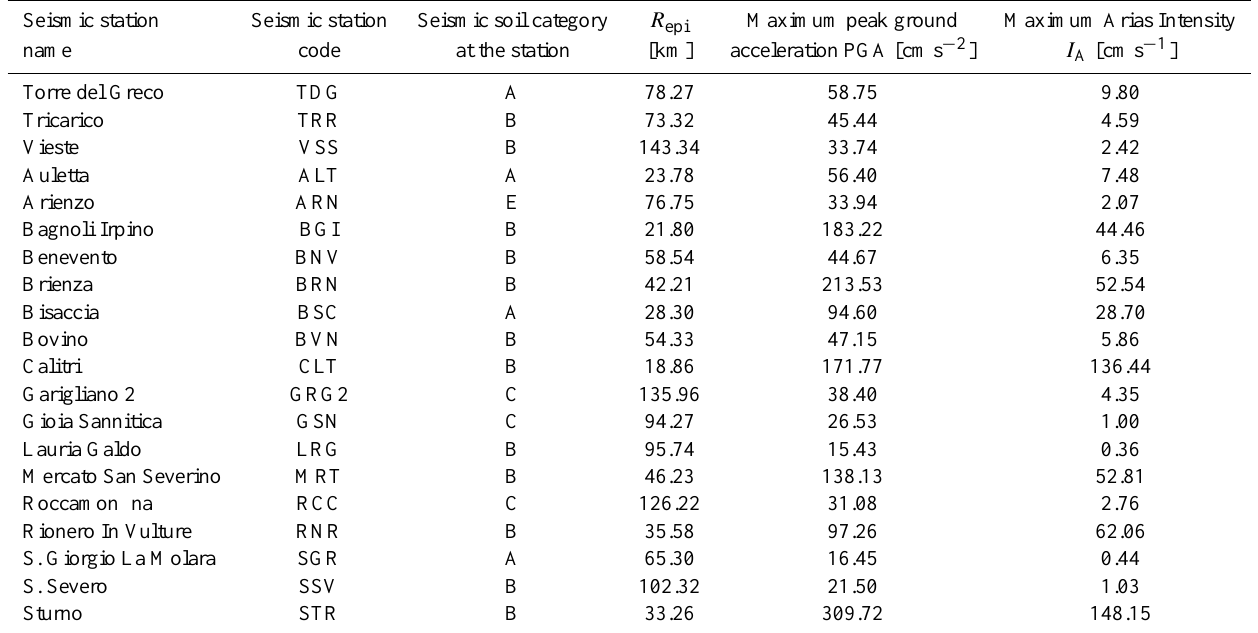
Table 4. Maximum values of PGA and I A measured at the seismic stations that recorded the Irpinia earthquake on 23 November 1980 at 18:34:53 local